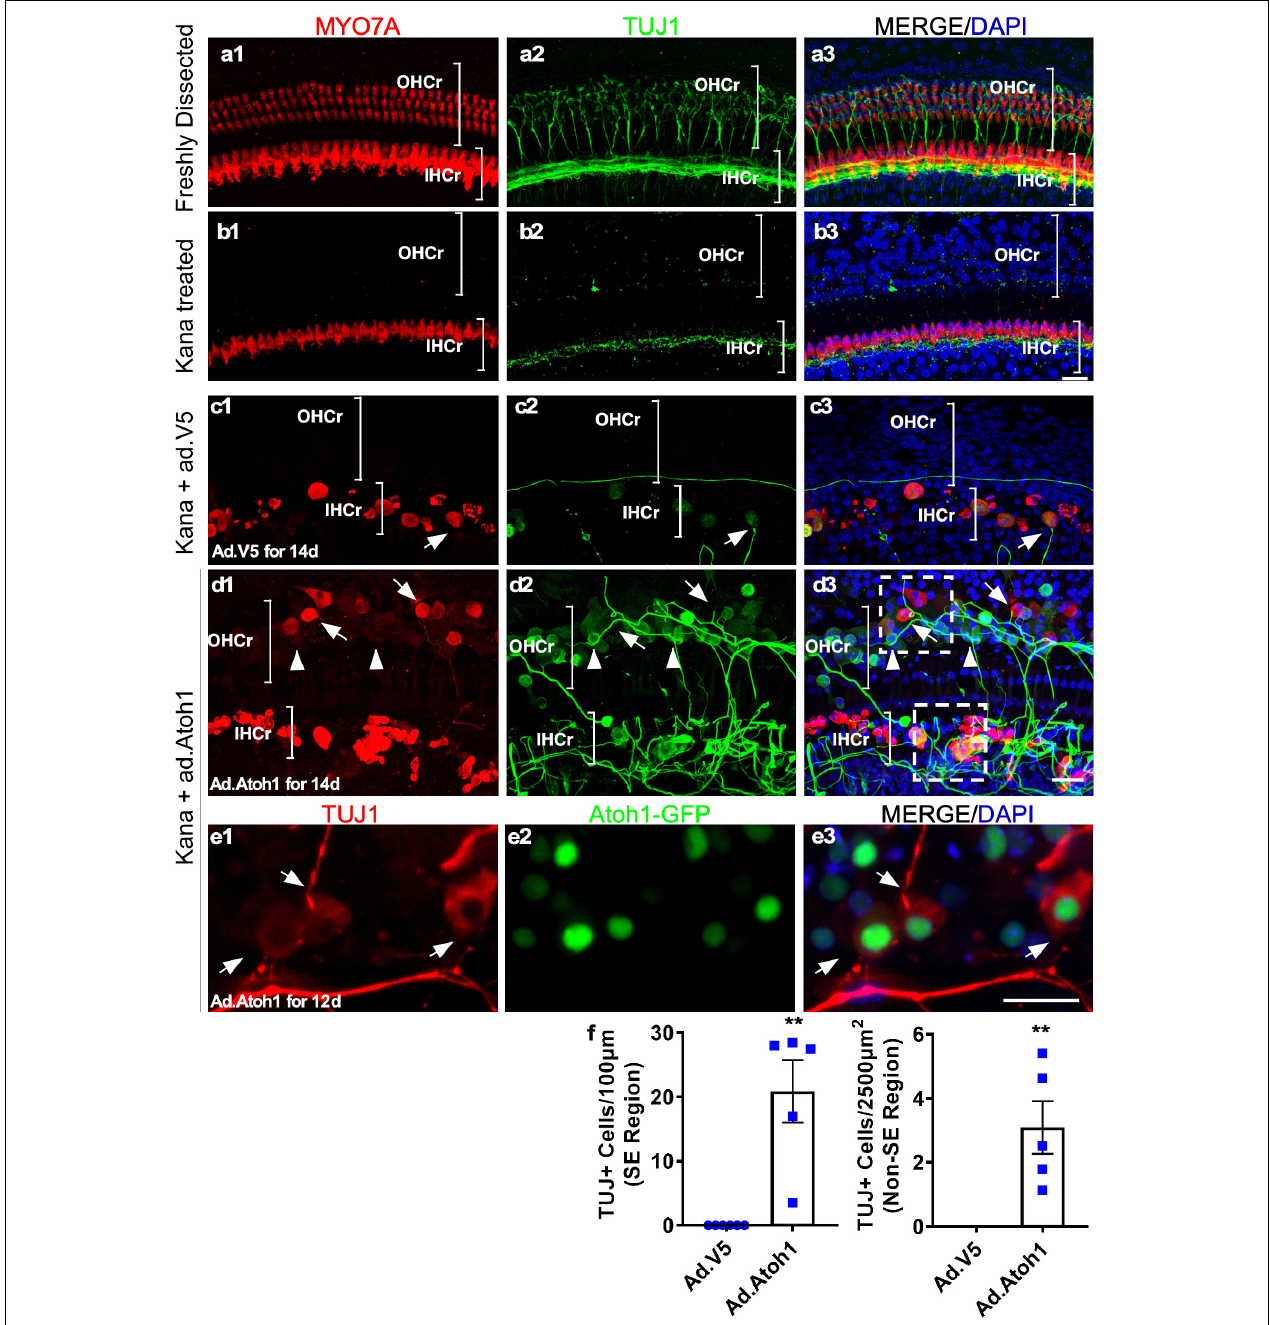
FIGURE 8 | Promotion of outgrowth of adult SGN neurites and formation of connections with regenerated HCLCs in adult cochlear explant culture. (a1–a3) A freshly dissected apex of the adult cochlea showed the distribution of neurites labeled with TUJ1. (b1–b3) Nine days postkanamycin/furosemide injection in vivo (d0 in culture), there was a complete loss of OHCs and an absence of neurites in the OHC region (OHCr, bracket). Neurites with lower density were scattered beneath the surviving IHCs. (c1–c3) Nine days postkanamycin/furosemide injection in vivo and 14 days after Ad-V5 infection in culture (d14), adult cochleae showed no HCs or neurites in the OHC region. There was a loss of a majority of neurites in the IHC region (IHCr, bracket). Some surviving IHCs were in direct contact with remaining neurites (arrow). (d1–d3) Nine days postkanamycin/furosemide injection in vivo and 14 days after Ad-Atoh1 infection in culture, adult cochleae showed regenerated HCLCs and neurites in the OHC region, and numerous disorganized neurites in the IHC region. HCLCs (MYO7A + ) were in direct contact with neurites (arrows). Many cells in the OHC region were TUJ1 + with weak or absent MYO7A signals, yet were in direct contact with neurites (arrowheads). The box areas in panel d3 refer to Supplementary Videos 3, 4 . (e1–e3) Atoh1–GFP cochlea samples 12 days after Ad-Atoh1 infection. The Atoh1-GFP + cells began to express TUJ1 marker and connect to neural fibers (arrows). (f) Quantification showed an increase of TUJ1 + cells after Ad-Atoh1 infection in culture. ** p < 0.01, Student’s t -test. Error bar, mean ± SEM, n = 5–6. n is the number of biologically independent cochlea samples. Scale bars: 20 µ m.